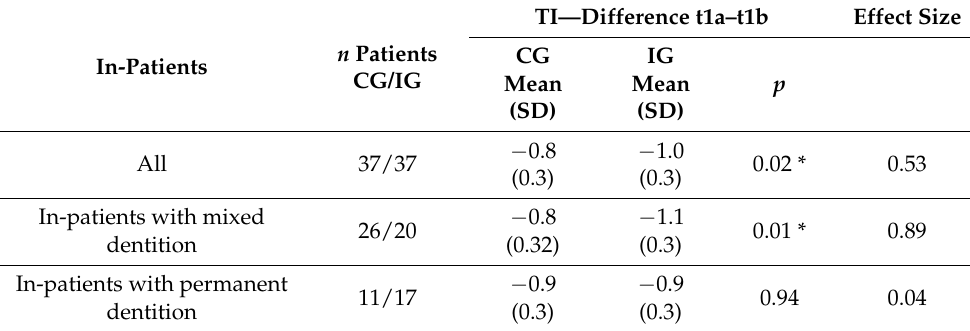
Table 5. Dental plaque reduction rates in IG and CG after autonomous tooth brushing in the mixed and permanent dentition and effect size of